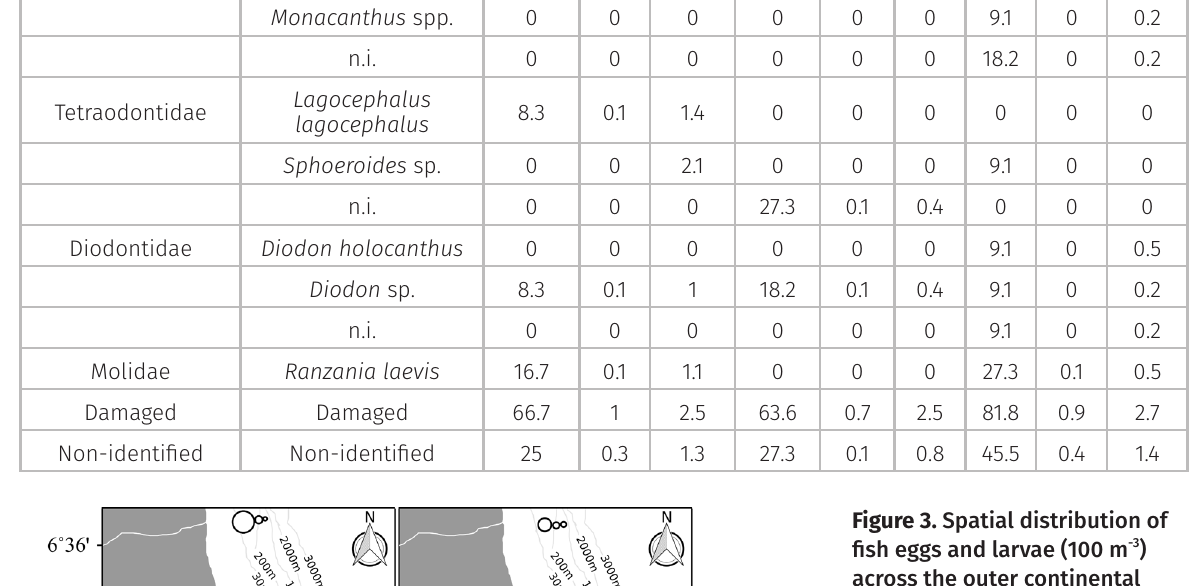
Figure 3. Spatial distribution of fish eggs and larvae (100 m -3 ) across the outer continental shelf – deep continental slope areas during 2010 (left) and 2012 (right). The empty circles represent the diurnal period and the gray-filled circles represent the nocturnal period. The area of the circles is proportional to the density values. The x represents missing data (damaged